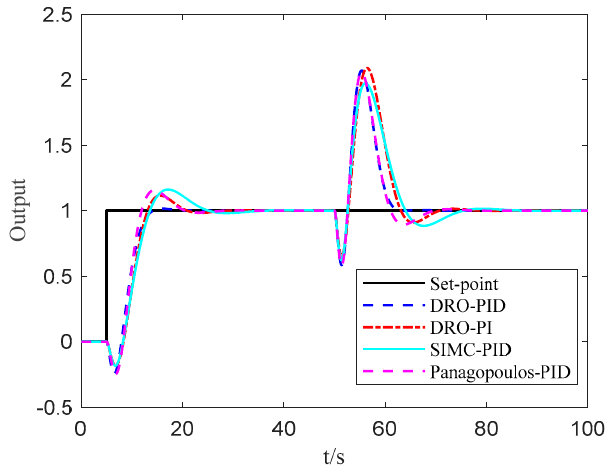
Figure 9. The output response of the step set-point and input disturbance for Example 2.